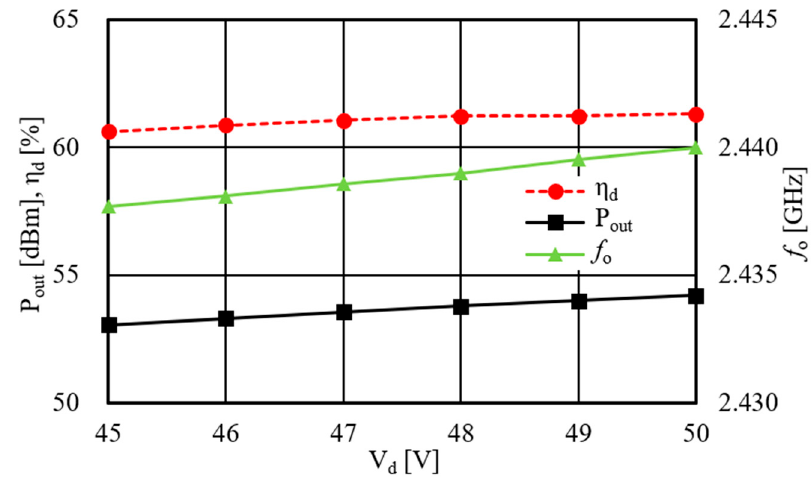
Figure 12. Measured output power and efficiency of the module with the circulator.